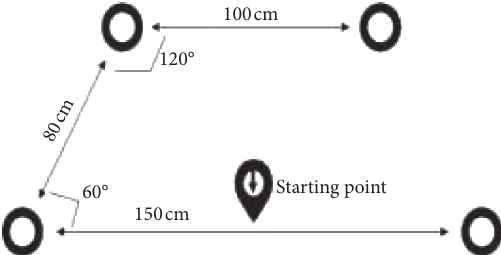
Figure 1: Dimensions of Fitlight Trainer ® during